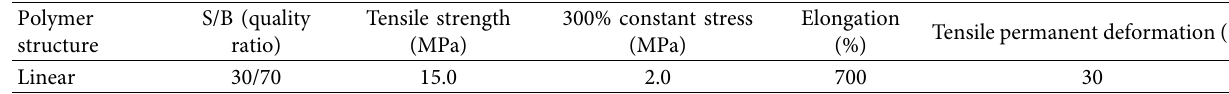
Table 2: Performance of polymer SBS.